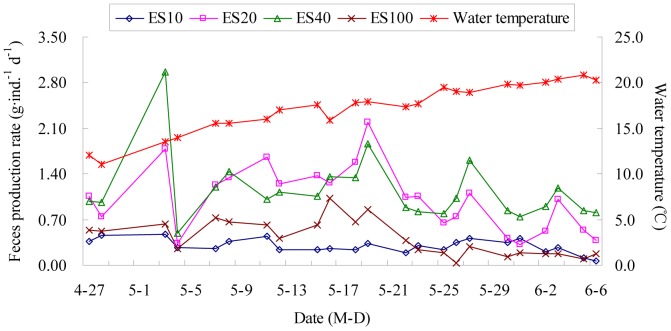
Variation in Fecal production rates (FPR; g·ind.
−1
 d
−1
) of 
Apostichopus japonicus
 during the experimental period.